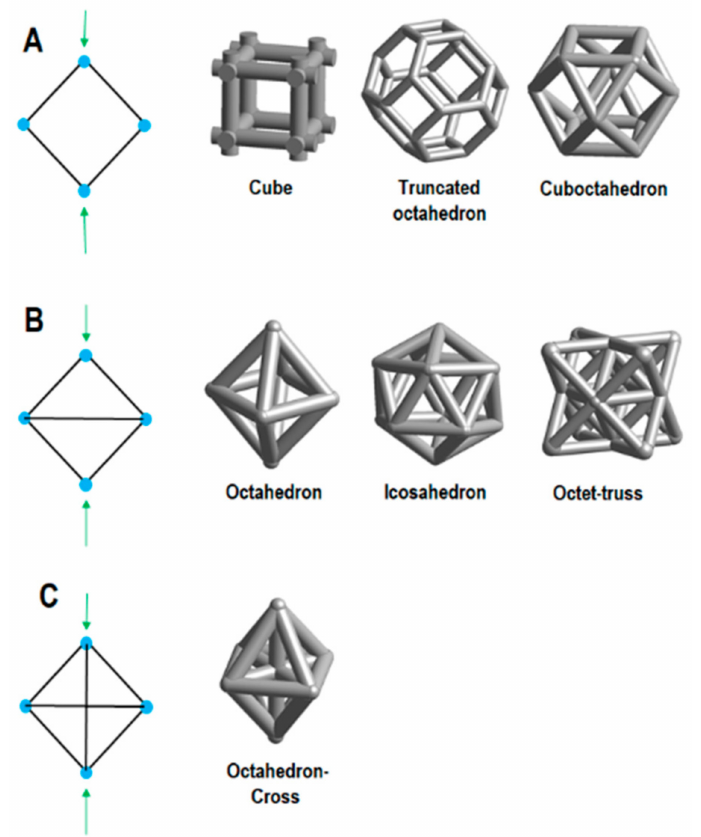
Figure 2. Classification of lattice structures as bending ( A ), stretching ( B ) or over-constrained ( C